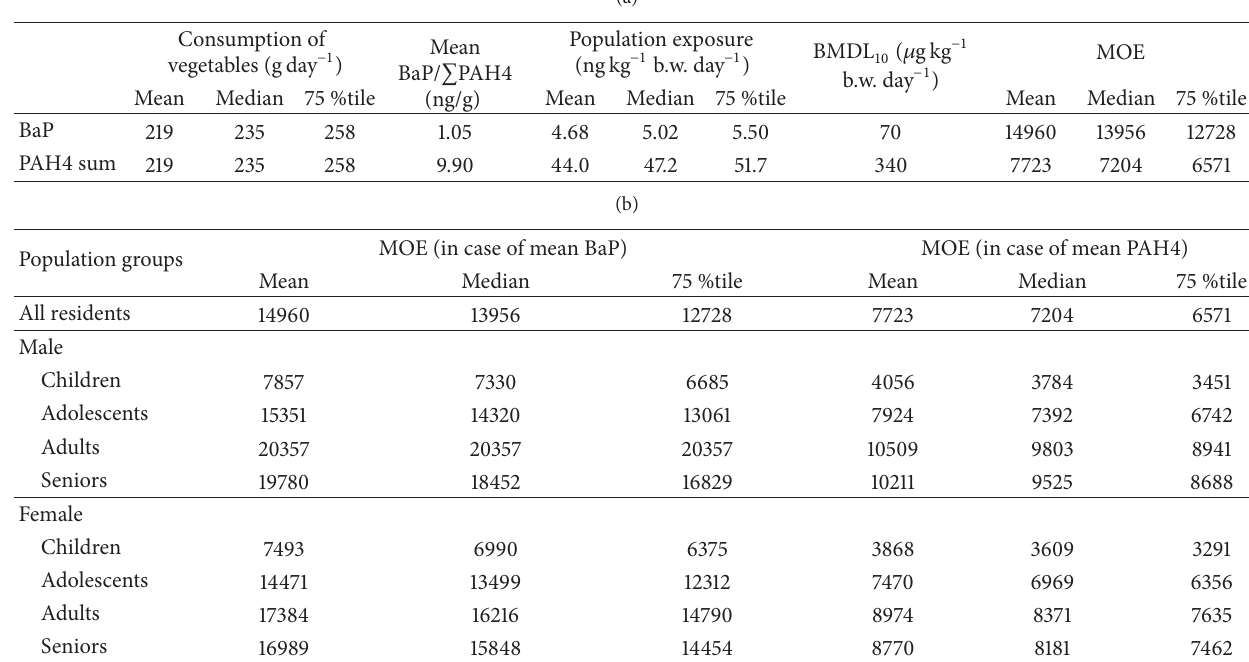
Table 4: MOE indicators within different population groups in